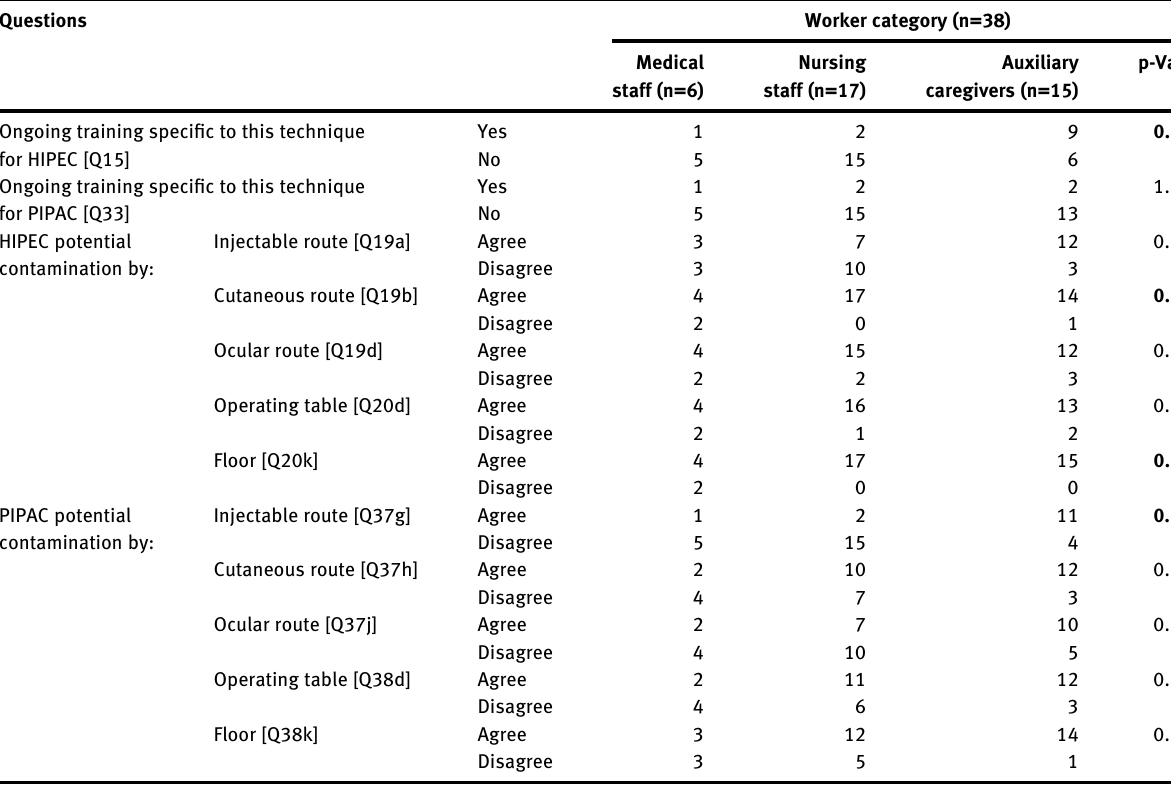
Table  B: Knowledge questions by worker categories.